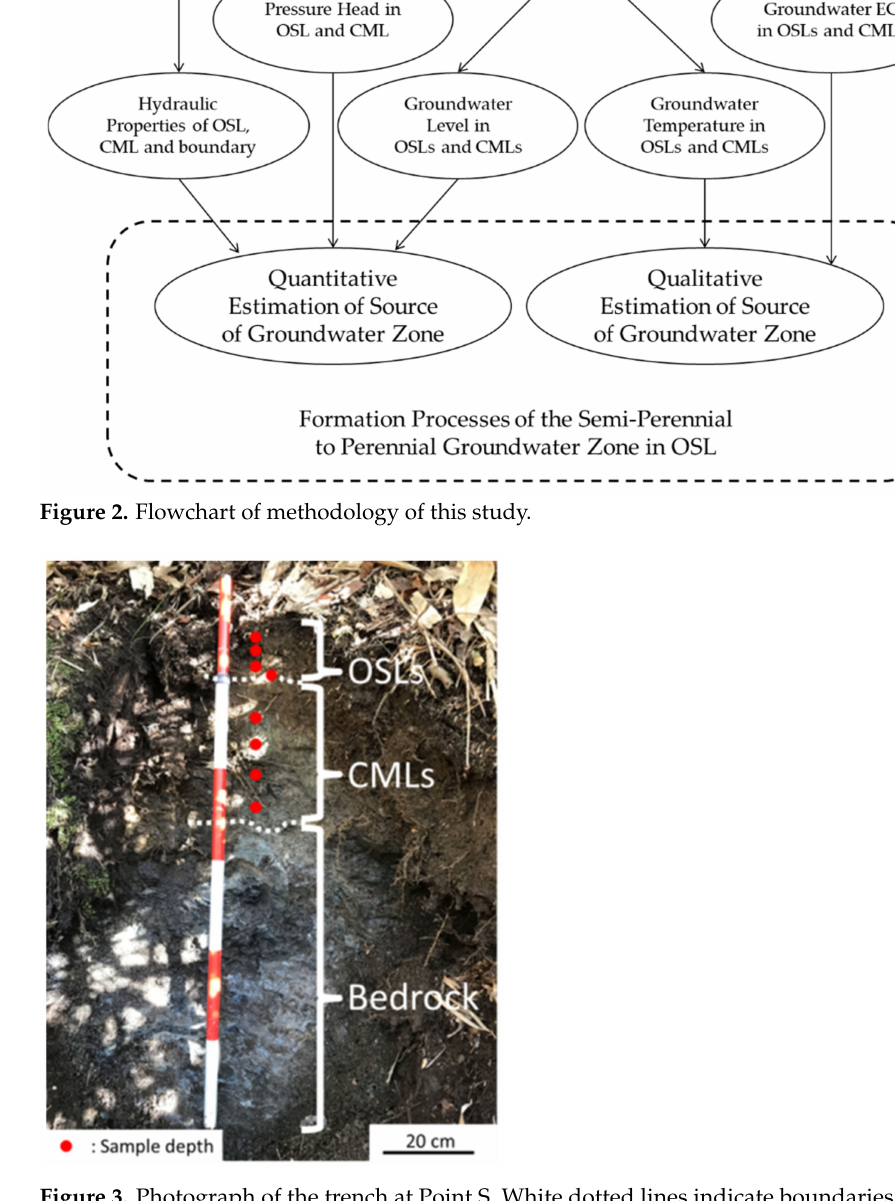
Figure 3. Photograph of the trench at Point S. White dotted lines indicate boundaries between the OSLs and CMLs and between the CMLs and bedrock. Solid red circles indicate the depths at which undisturbed core samples were